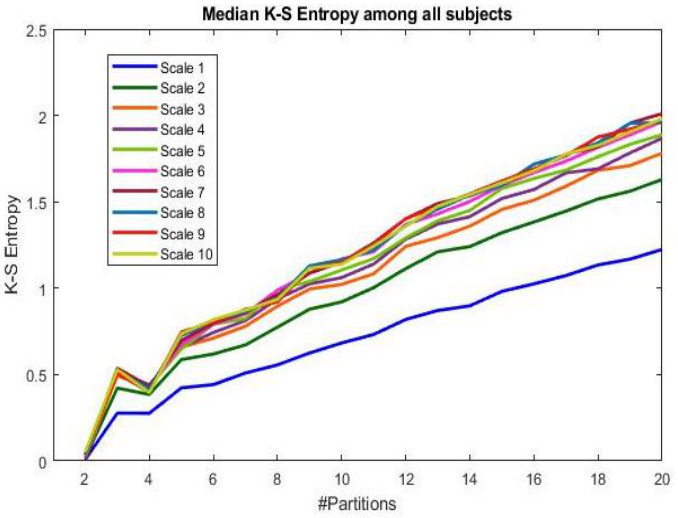
Figure 2. Median across all subjects (i.e., both young and elderly groups) of the MKSE as a function of the cardinality of the uniform partitions